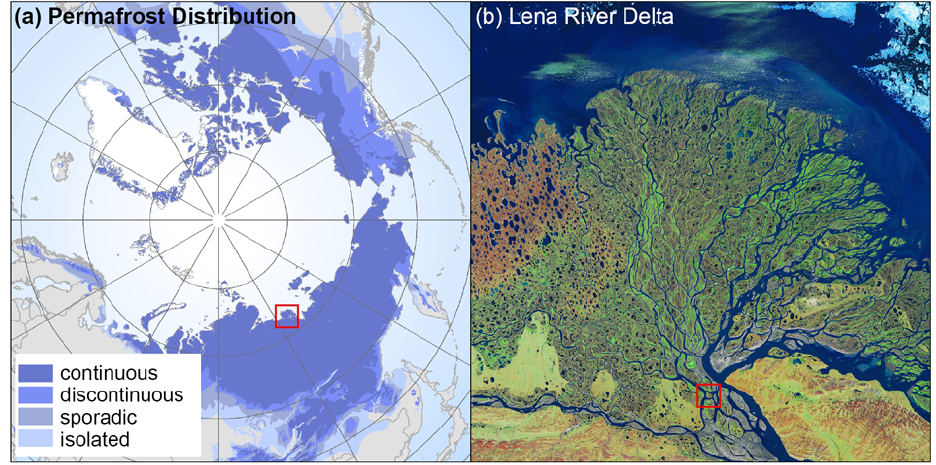
Fig. 1. (a) Circumpolar permafrost distribution (Brown et al., 1998) and the Lena River Delta. (b) Location of the Samoylov study site within the Lena River Delta, Eastern Siberia (NASA,